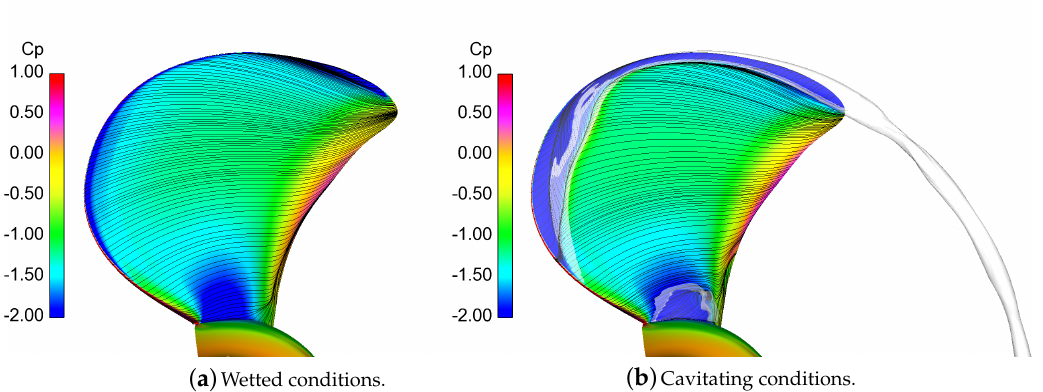
Figure 14. Surface restricted streamlines and non-dimensional pressure coefficients on the suction side of the blade surface. In the cavitating case, the iso-surface of void fraction value of 0.1 is shown as transparent grey.